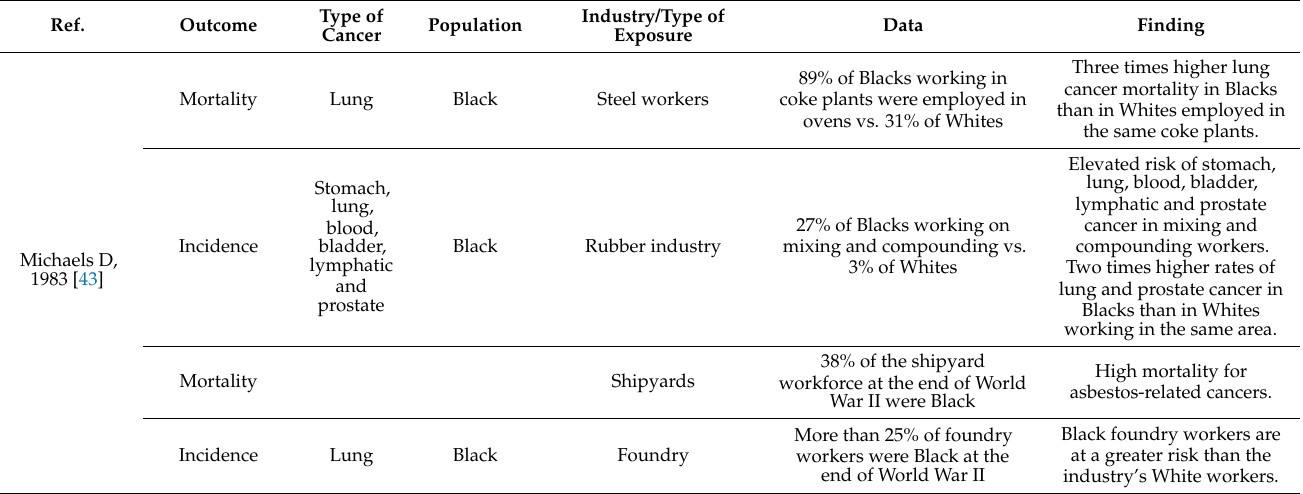
Table 2. Selected studies reporting information on education and race/ethnicity as a reason for occupational